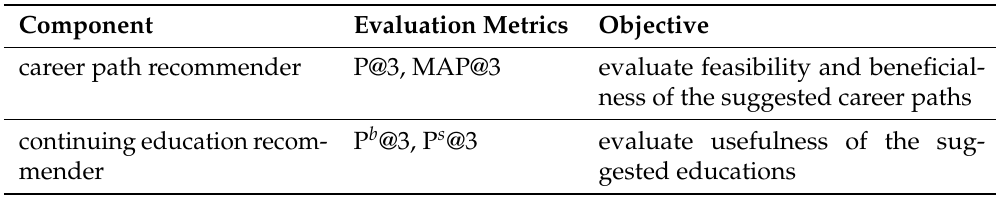
Table 5. Evaluation components, metrics, and objectives for the recommender system (Sections 4.2 and